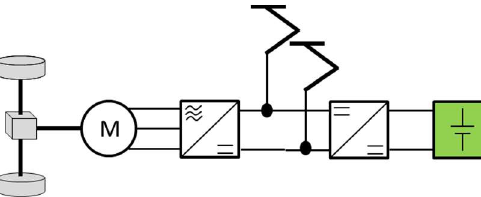
Figure 4. The drivetrain topology of the modeled overhead catenary truck.